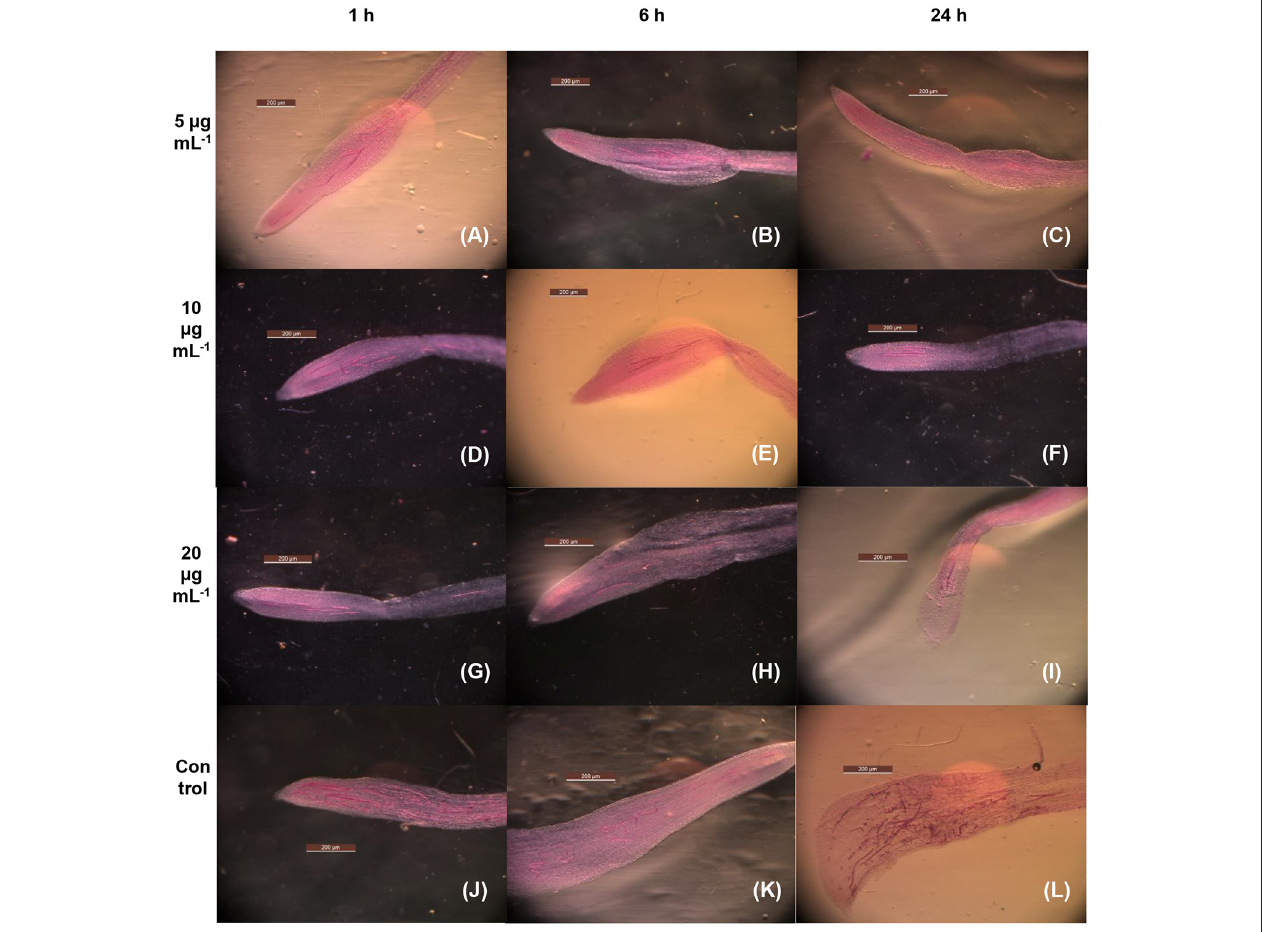
FIGURE 4 | Microscopic images of tomato roots for the infectivity of MEO-treated M. incognita exposed at 5 µ g mL − 1 for 1h (A) , 5 µ g mL − 1 for 6h (B) , 5 µ g mL − 1 for 24h (C) , 10 µ g mL − 1 for 1h (D) , 10 µ g mL − 1 for 6h (E) , 10 µ g mL − 1 for 24h (F) , 20 µ g mL − 1 for 1h (G) , 20 µ g mL − 1 for 6h (H) , 20 µ g mL − 1 for 24h (I) , control for 1h (J) , 6h (K) , and 24h (L)